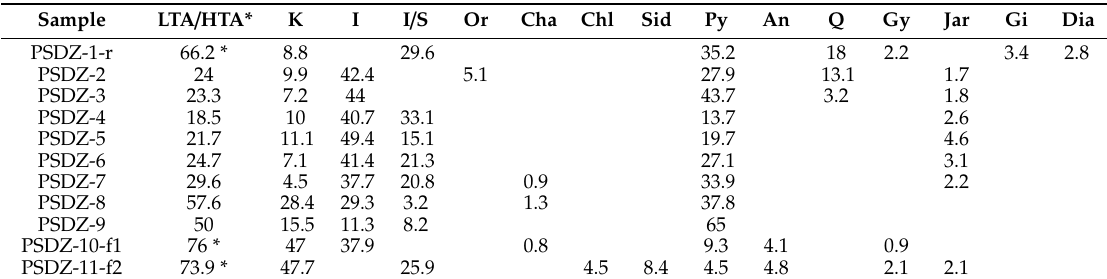
Figure 3. Low temperature ash (LTA) yields versus high temperature ash (HTA) yields of the Donggou coal samples. The red diagonal line in the plot indicates equality. Table 2. Mineralogical compositions of coal LTAs and non-coal samples in the Donggou mine by XRD and Siroquant analysis (wt. %).